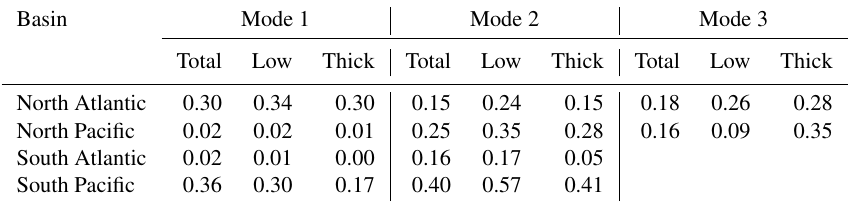
Table 1. The fraction of the basin-averaged cloud occurrence trends in Fig. 1 that can be explained by each MCA mode (Fig. 3). Calculation is explained in Appendix A. Because most of the observed trends (Fig. 1) are changes in low cloud (CTH < 2.5km) and in thick cloud (OD > 23), separate estimates are given for these categories. Notably, some MCA modes account for very little of the basin-averaged trend. This is due to spatial cancellation in the basin average. In NP1 for instance there are increases in low cloud in the eastern side of the basin that are largely balanced by decreases in low cloud on the western side (see dipole loading pattern Fig. 3 NP1). Basin Mode 1 Mode 2 Mode 3 Total Low